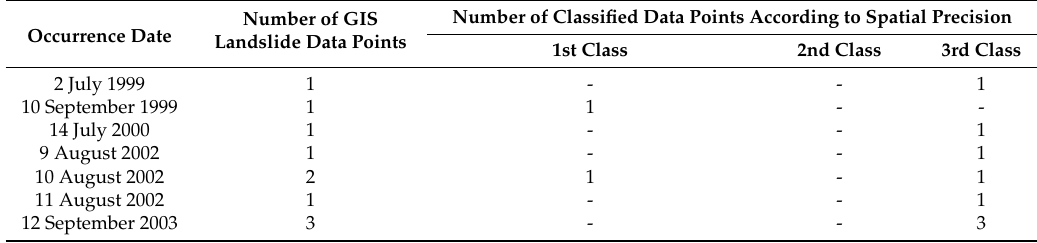
Figure 8. Historical landslide database in the form of GIS point feature classes including the distribution of ( a ) data recorded from 1999 to 2016 and classified by spatial precision and ( b ) 1st and 2nd class spatial precision data recorded from 2009 to 2016 and reclassified by landslide type. Table 2. Classification of historical landslide data according to occurrence date and spatial